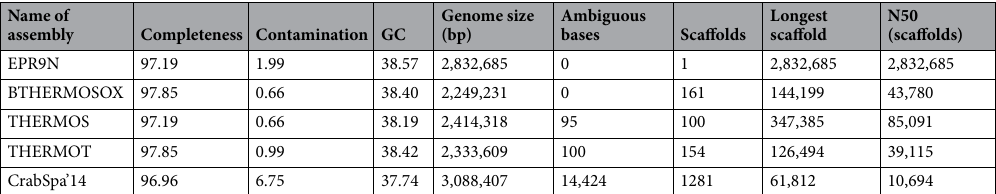
Table 2. Genome completeness, contamination, and assembly statistics of B. thermophilus symbionts.